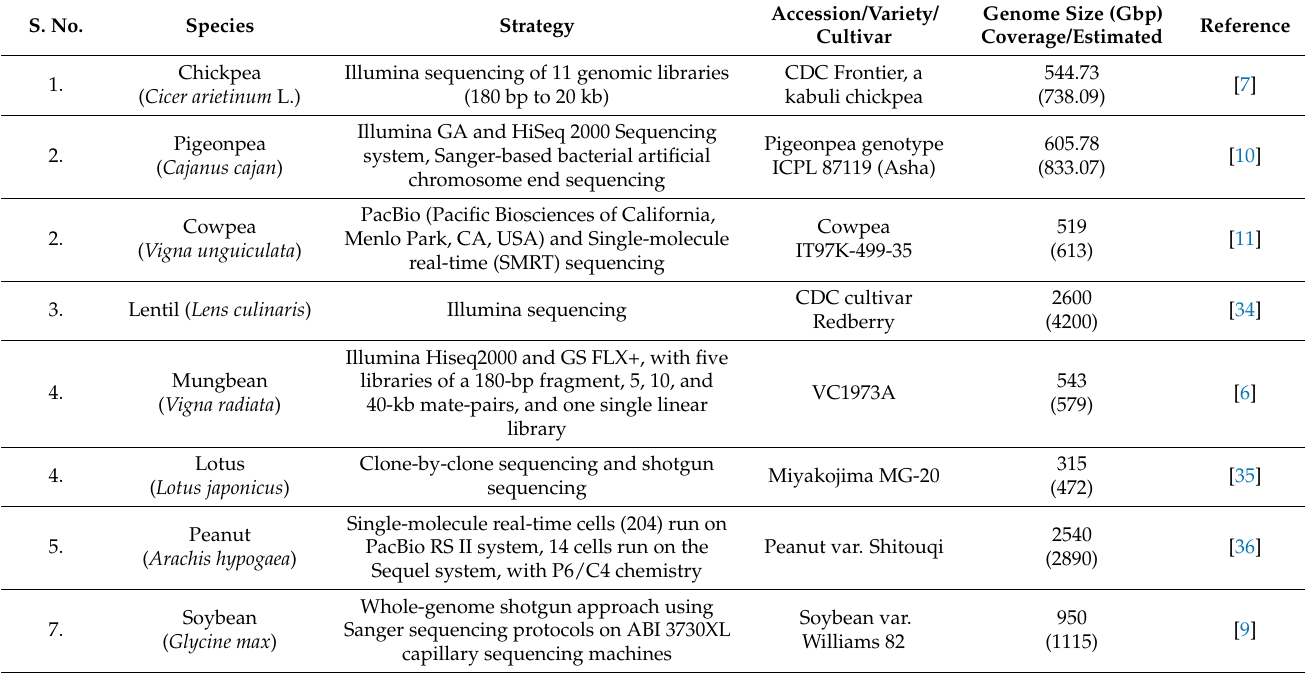
Table 1. List of published reference genomes of major